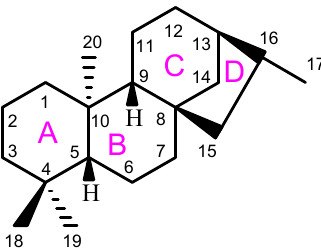
Figure 1. General structure and numbering system of ent -kaurane diterpenes.